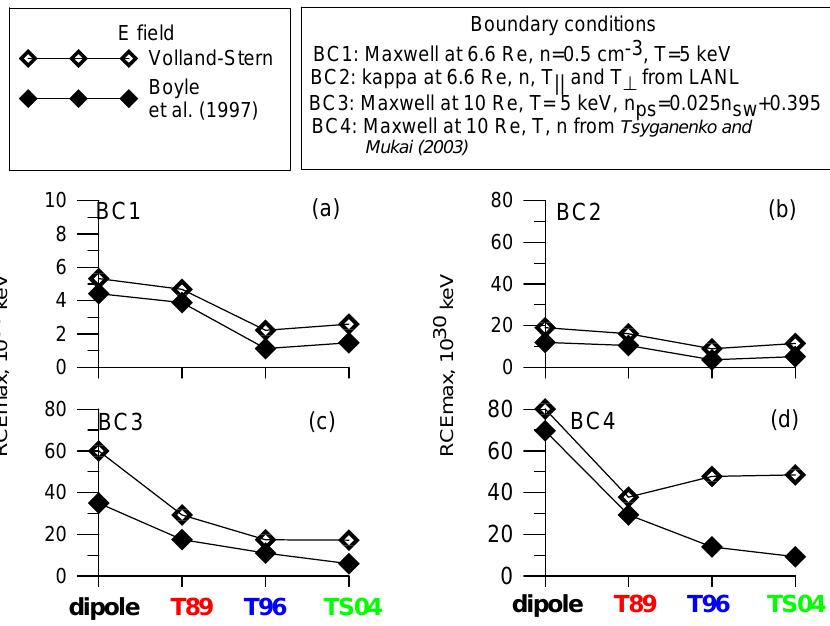
Fig. 5. Peak magnitudes of the ring current energy profiles shown in Fig. 3 during 21–22 October 1999 storm, similar to Fig. 4.